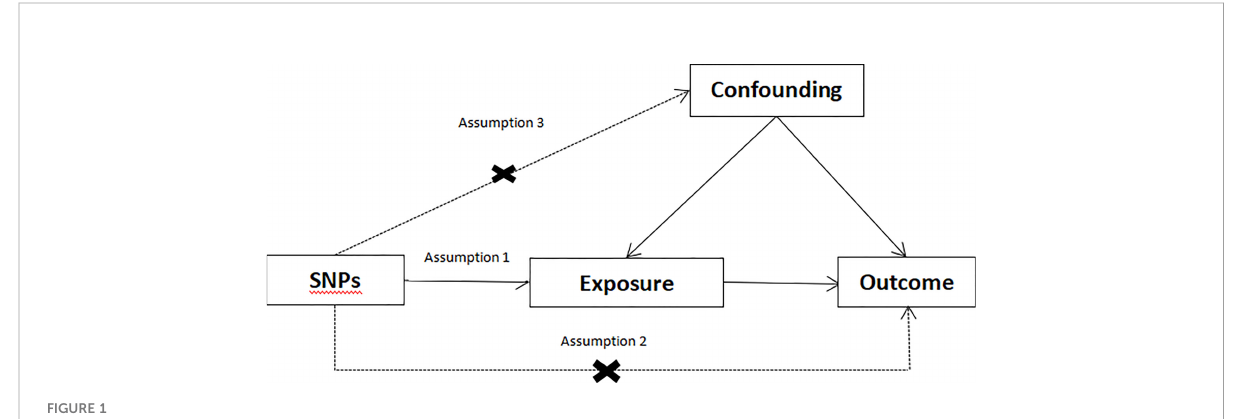
FIGURE 1 Conceptual framework diagram for Mendelian randomization